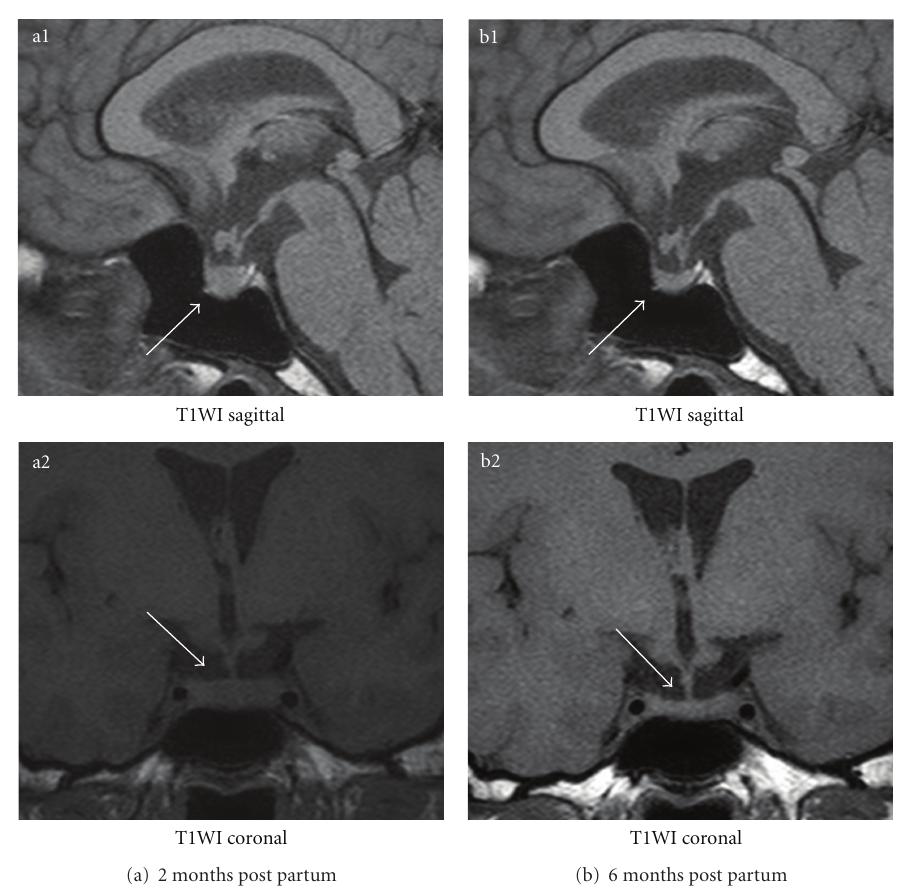
Figure 2: Sequential magnetic resonance imaging (MRI) (T1 weighted image: T1WI) demonstrated changes of the pituitary gland. At 2 months post partum, MRI revealed a normal pituitary gland ((a1) T1WI sagittal, (a2) T1WI coronal). At 6 months post partum, MRI revealed atrophy of the pituitary gland and empty sella ((b1) T1WI sagittal, (b2) T1WI coronal). At 6 months post partum, she had empty sella on MRI. The arrows indicate the pituitary